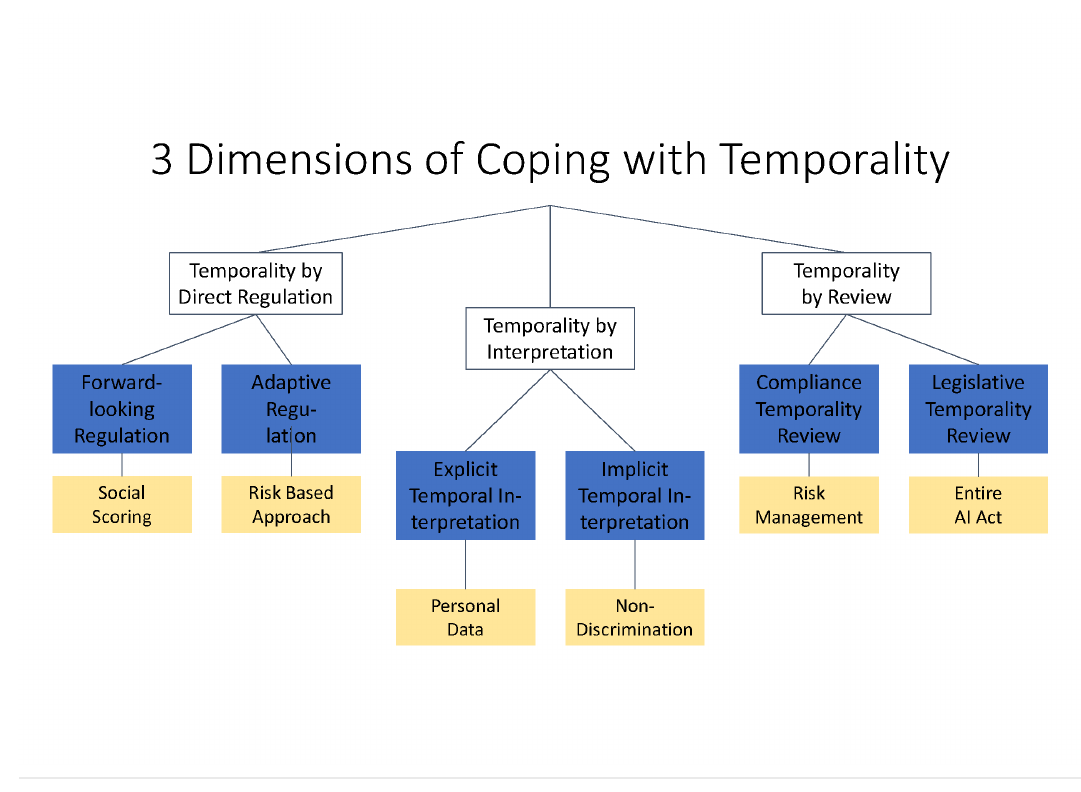
FIGURE 1: An overview of dimensions of temporality in law (Source: Authors' own